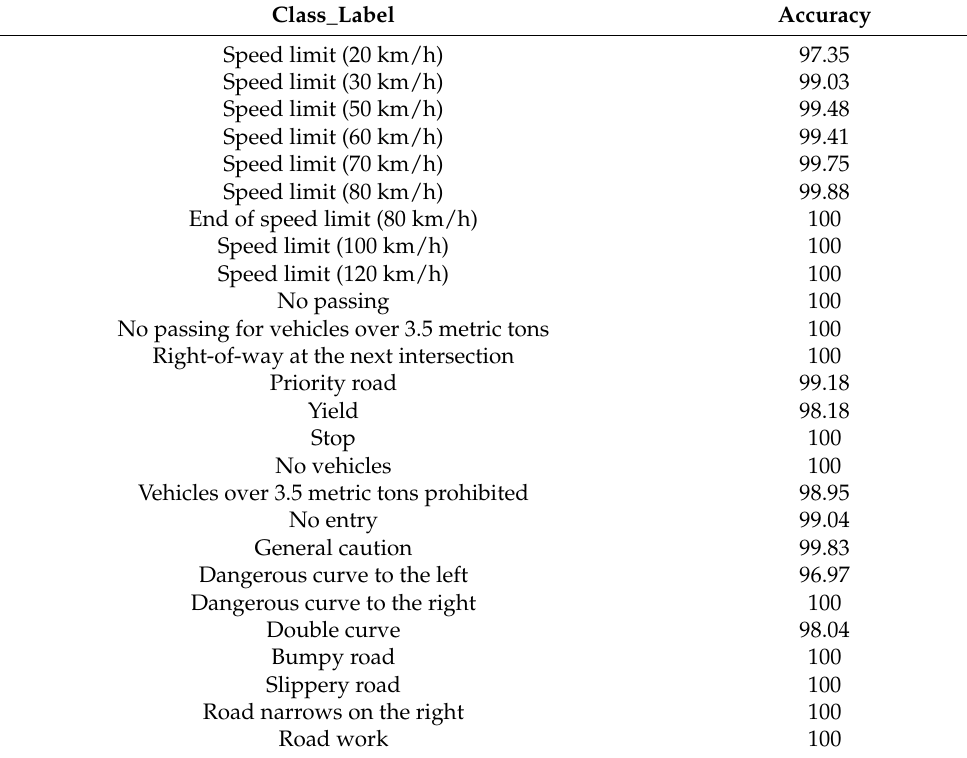
Table 5. Accuracy level of different class